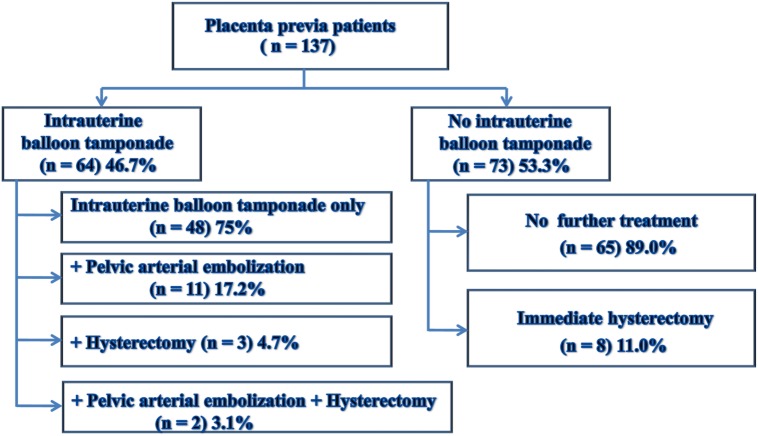
Management for Placenta Previa Patients.